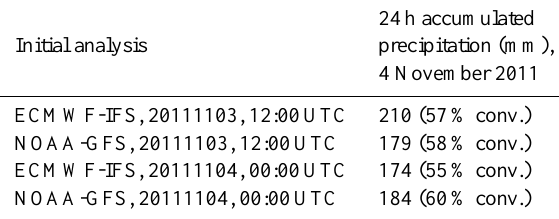
Table 4. As Table 3 but for the GE